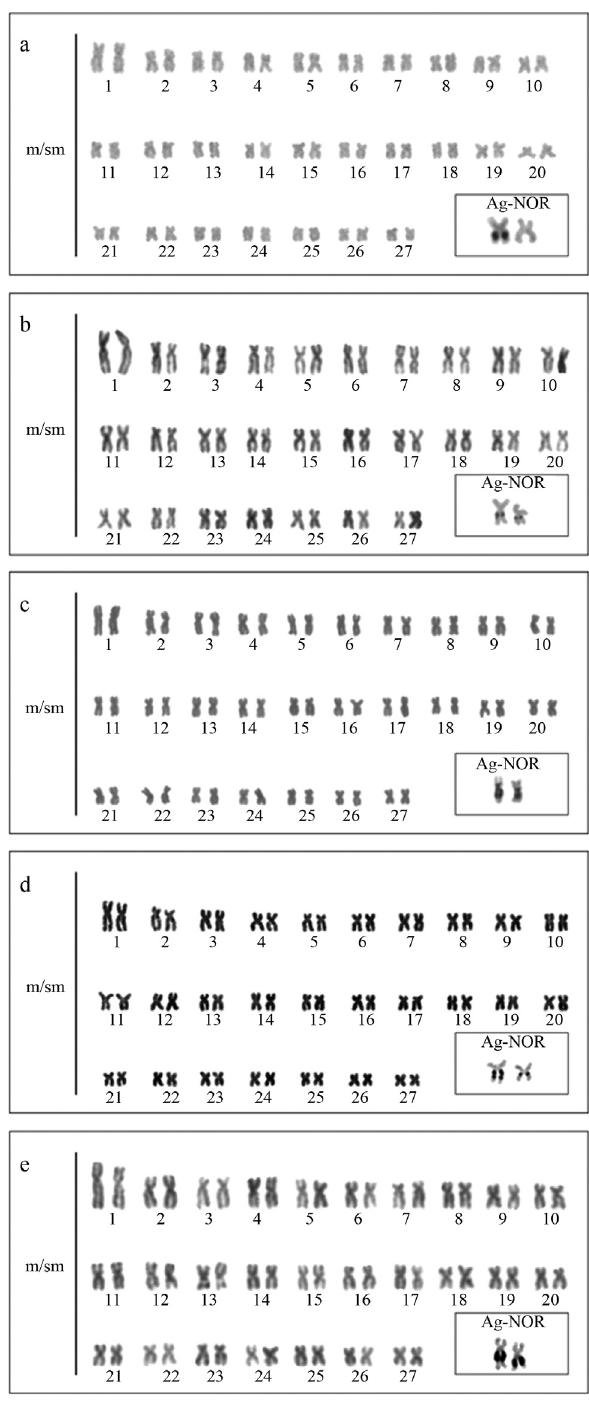
Figure 1 - Karyotypes of the five Prochilodus species analyzed in this work: (a) P. argenteus ; (b) P. brevis ; (c) P. costatus ; (d) P. lineatus and (e) P. nigricans . In the boxes, the AgNOR-bearing pair.